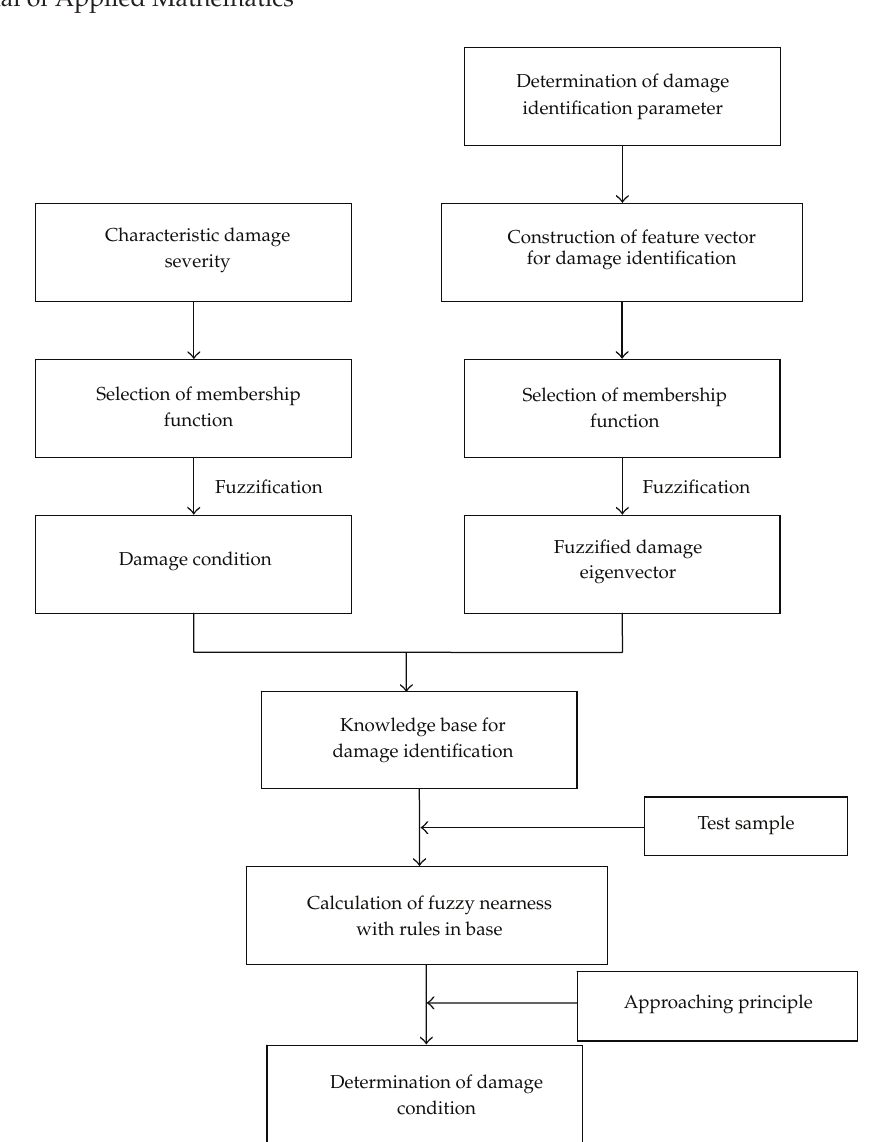
Figure 1: Calculation process for damage identification based on fuzzy nearness and approaching